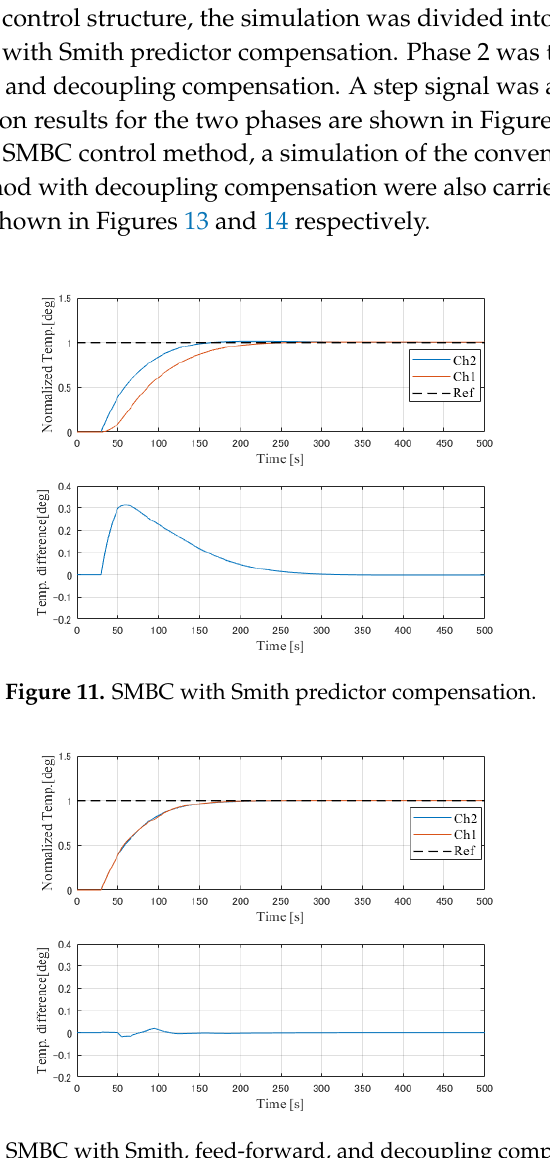
Figure 12. SMBC with Smith, feed-forward, and decoupling